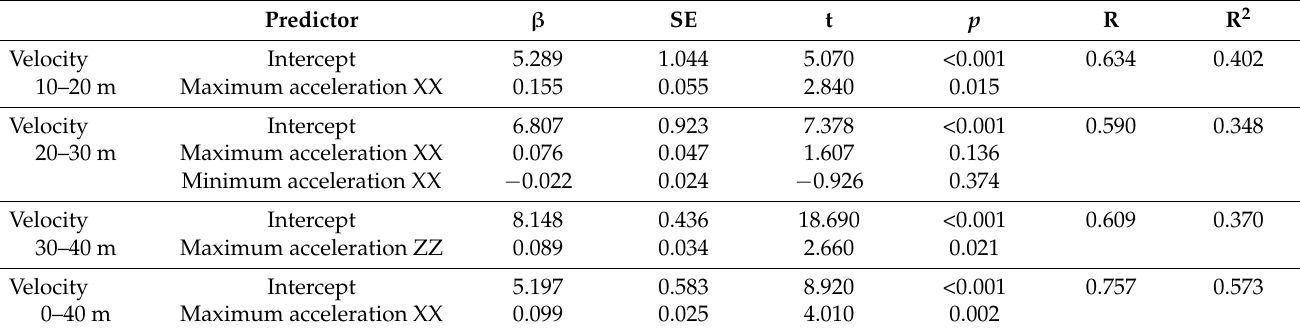
Table 4. The regression coefficients used to explain the acceleration values obtain by the IMU.